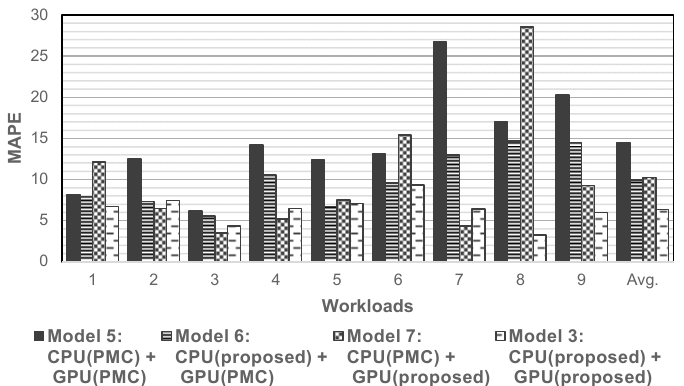
Figure 10. Test results of four holistic power models built with combinations of proposed methods and existing methods.